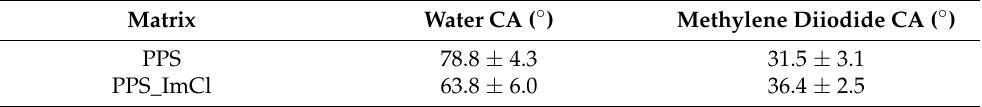
Table 3. Contact angles from goniometer measurements. Matrix